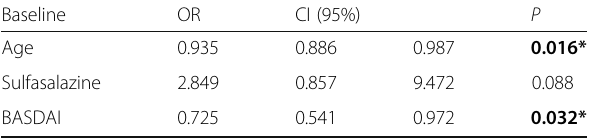
Table 4 Remission predictors: multivariate analysis